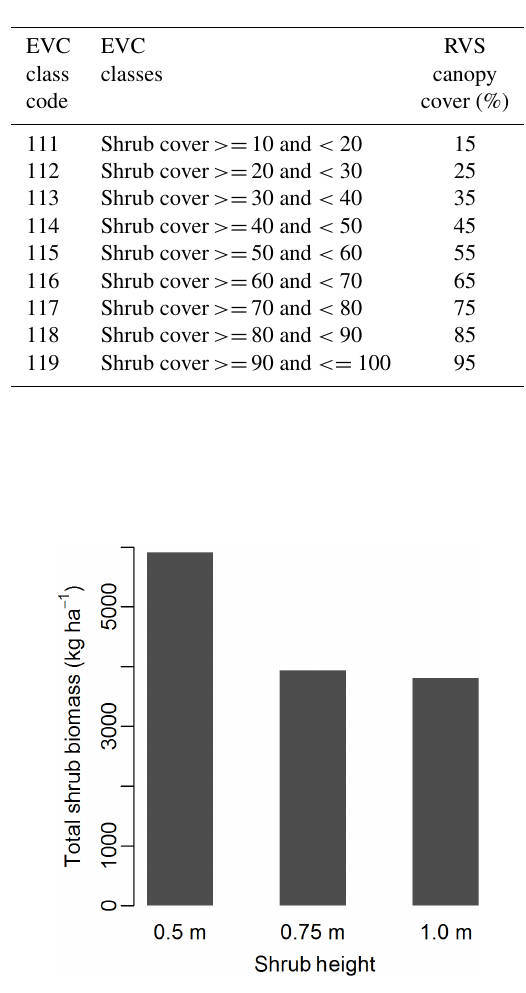
Table C2. Thematic classes representing shrub canopy in the LANDFIRE EVC product and the associated canopy cover used in the RVS fuel modeling system.